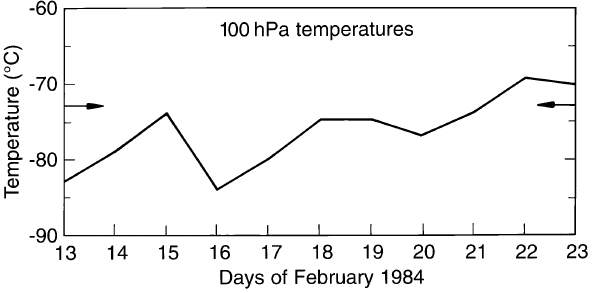
Fig. 4. 100-hPa temperatures over Kola peninsula from 13 Febru- ary to 23 February 1984. Arrows indicate the threshold temperatures for type 1 PSC formation